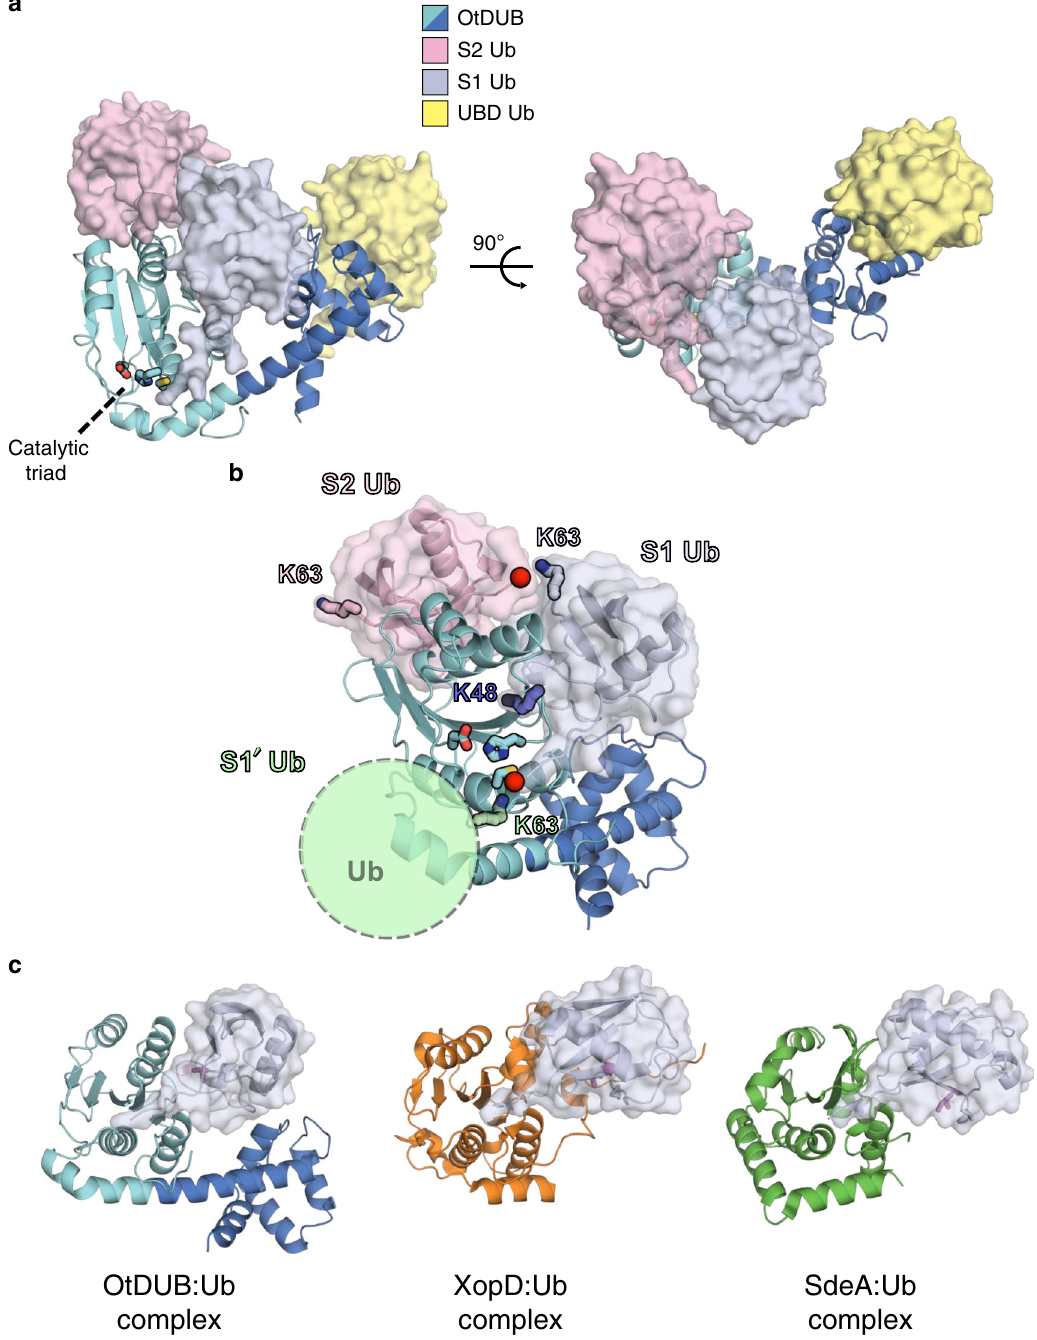
Fig. 2 OtDUB 1 – 259 – ubiquitin crystal complex reveals three distinct ubiquitin-binding sites. a Overall structure of the OtDUB 1 – 259 – ubiquitin complex with OtDUB 1 – 259 in cartoon representation and individual ubiquitin molecules in cartoon/surface representation. Catalytic triad residues shown as sticks in a , b . b Schematic of the potential K63 ubiquitin-chain linkage, highlighting the arrangement of two neighboring ubiquitin molecules bound to OtDUB 1 – 259 . K63 side chains shown as sticks and C-terminal glycines shown as red spheres. c Structural comparison of OtDUB 1 – 259 – S1 ubiquitin complex with other bacterial DUB – ubiquitin complexes. For XopD – Ub (orange, PDB ID: 5JP3) and SdeA – Ub (green, PDB ID: 5CRB), DUBs are shown as cartoon, S1 ubiquitin is shown as cartoon/surface, and Ile44 is shown as magenta